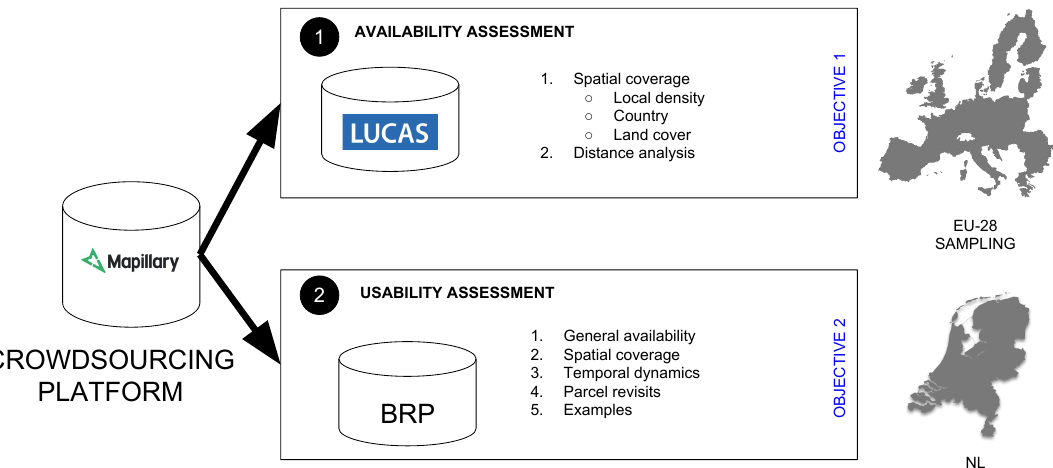
Figure 1. The first objective of the paper is to assess the spatial availability of crowdsourced street-level imagery data across the European Union (EU-28) based on the Land Use and land Cover Area frame Survey (LUCAS). The second, third, and fourth, objectives are to assess the potential usability of such images to generate in-situ data relevant for crop monitoring in the Netherlands (NL) using to the Dutch agricultural parcel registry, i.e., Basisregistratie Gewasparcelen